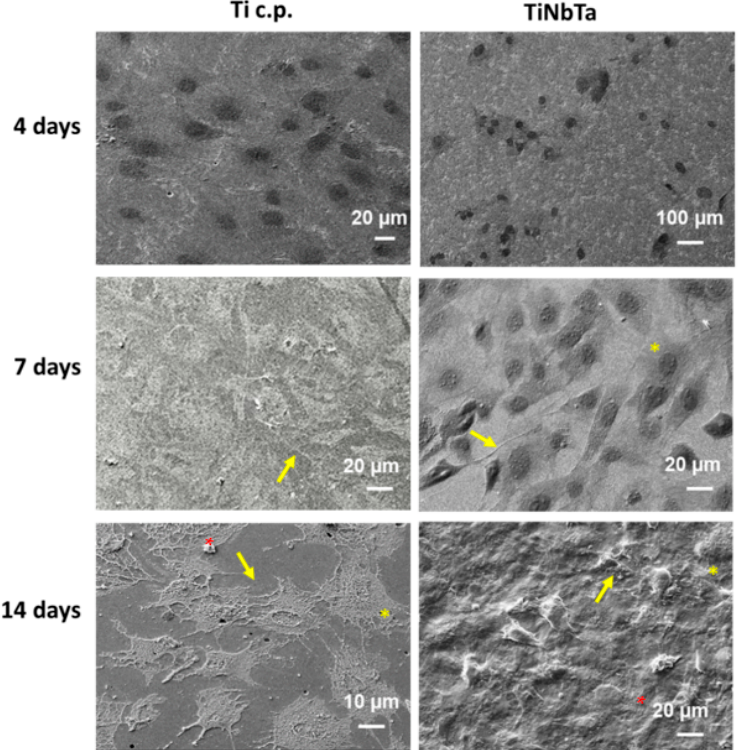
Figure 7. SEM micrographs at 4, 7, and 14 days of osteoblast culture growing on fully dense Ti c.p. or TiNbTa surface. Cell morphology and osteoblast proliferation are observed with filopodia marked by yellow arrows and lamellipodia indicated by yellow asterisks (flattened extension of a cell, by which it adheres to a surface ). The small hexagonal-structure vesicles are indicated by a red asterisk, which suggests hydroxyapatite on the cell surface.